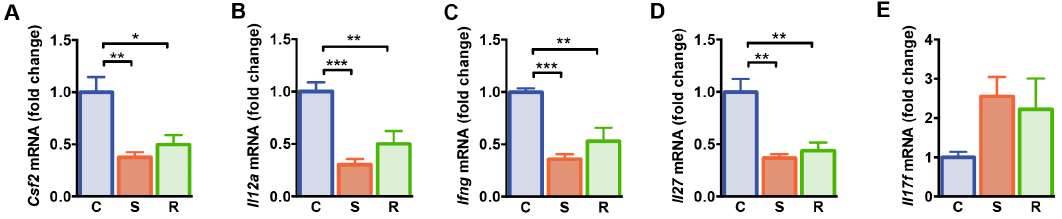
Figure 2. Gene expression analysis of splenocytes from control, susceptible and resilient mice after 10 days of social defeat. ( A ) mRNA expression of Csf2 , ( B ) Il12a , ( C ) Ifng , ( D ) Il27 , and ( E ) Il17f . Expression levels were normalized to the mean expression of housekeeping genes Gapdh and Hsp90ab1. Fold